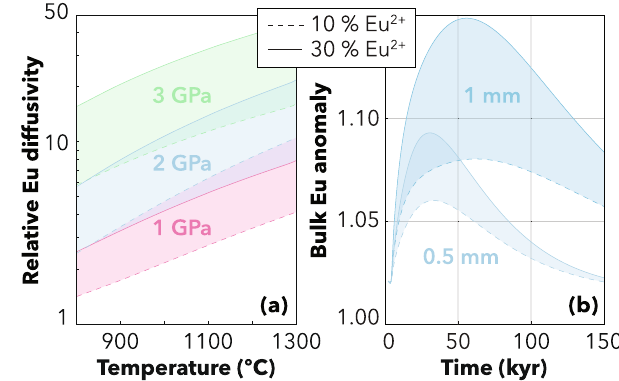
Fig. 3 | Relative Eu diffusivity and development timescale of kinetic Eu anomalies. The relative diffusivity ( a ) is calculated as the diffusivity of a mixture (Eu mix ) of divalent and trivalent Eu divided by the diffusivity of pure Eu 3+ . The development timescale ( b ) is shown as the time evolution of the bulk anomaly in clinopyroxene (calculated as the integral of the core-to-rim pro fi le in spherical coordinates) modelled at 2GPa and 1300°C.